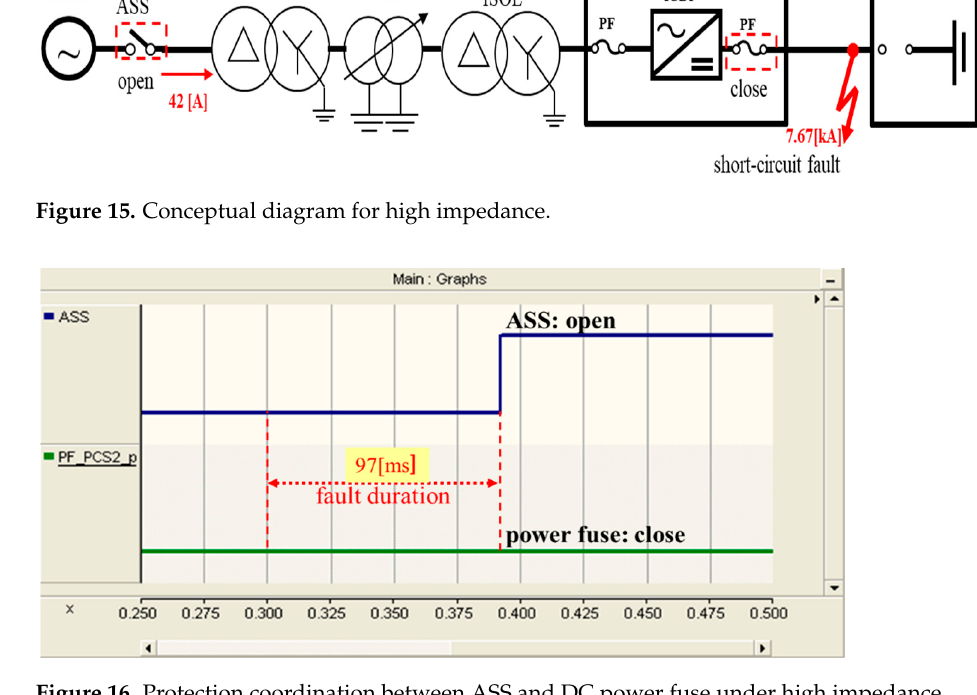
Figure 16. Protection coordination between ASS and DC power fuse under high impedance.